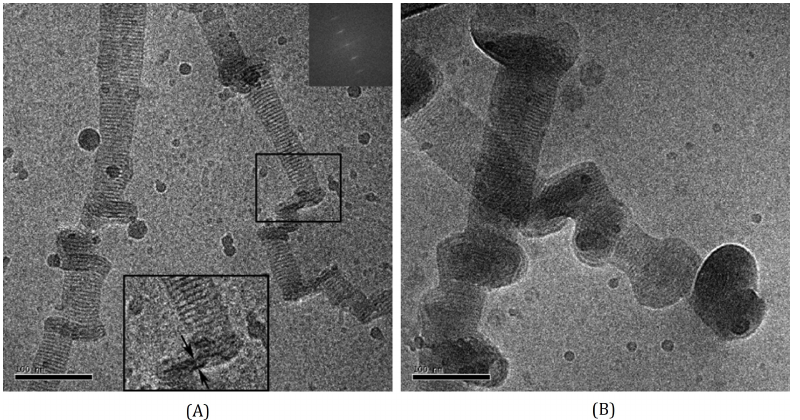
Figure 8. Nanoribbons formed by PEG 45 -b-PCpEChol 3 . ( A ) Starting polymer concentration = 0.1 wt%; ( B ) starting concentration = 0.5 wt%. Note that the smectic stripes formed at the sides of the ribbons. Reprinted with permission from Jia et al., Langmuir , 2012 , 28 , 11215–11224 [51].